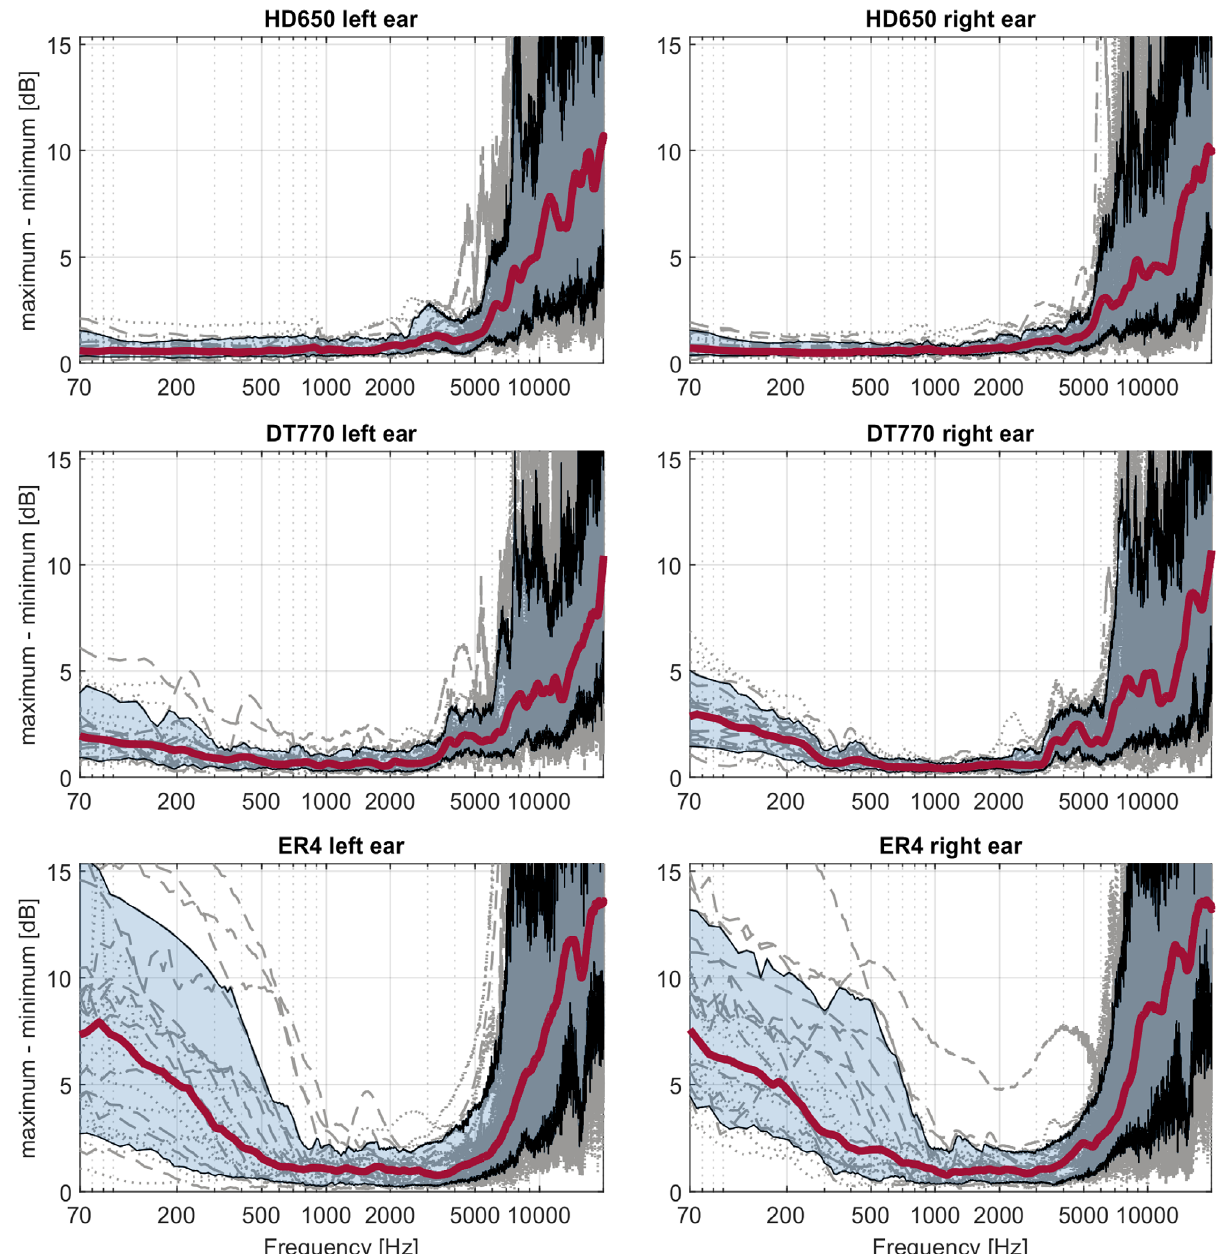
Figure 3. Maximum deviations for repositioning the headphones eight times for each participant in Aachen and in Oldenburg. For each frequency the maximum level [dB] minus the minimum over up to eight repetitions is taken. Left diagram relates to the left and the right diagram to the right ear. Red line shows the median (smoothed by one-twelfth moving average window). In transparent blue the range of 75% of measurement data around the median is plotted. Gray lines indicate an individual measurement. Dashed lines indicate a measurement in Aachen, dotted lines measurements in